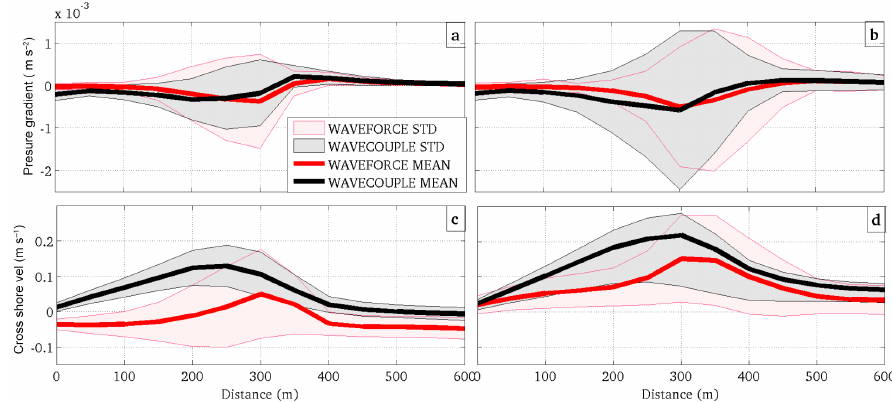
Figure 10. Sections of pressure gradient per density unit and surface cross-shore velocities for experiment 1 (a, c) and experiment 2 (b, d) . The thick lines show the mean while the shaded areas are the standard deviations. Distances are measured from the coastline along the section defined in Fig. 9d. Negative pressure gradient is directed offshore.